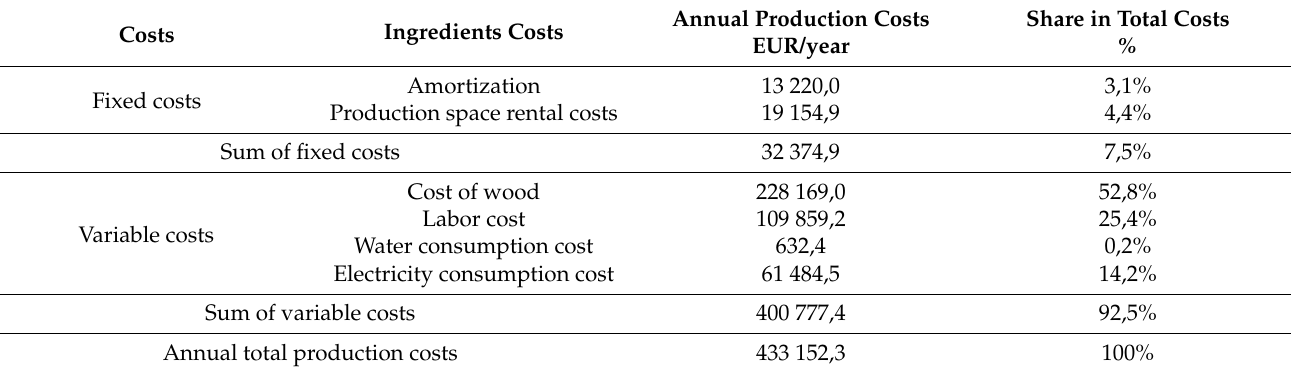
Table 9. Annual production costs of second-generation bioethanol from wood